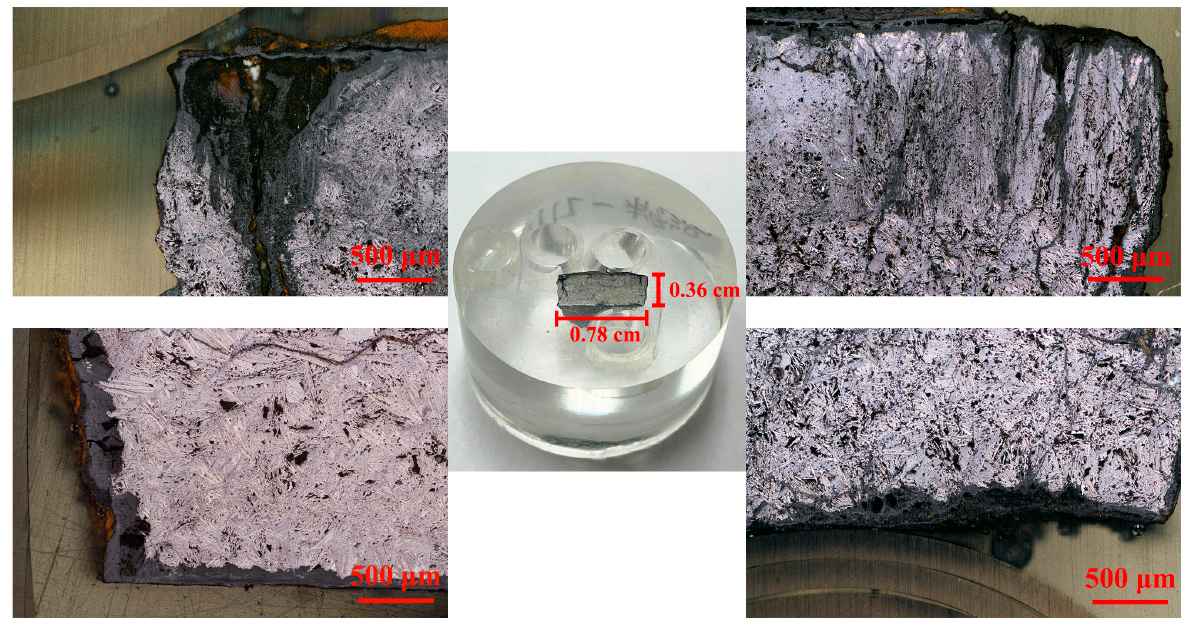
Figure 2. Digital and microscopic graphs of the cross-section of archaeological iron.